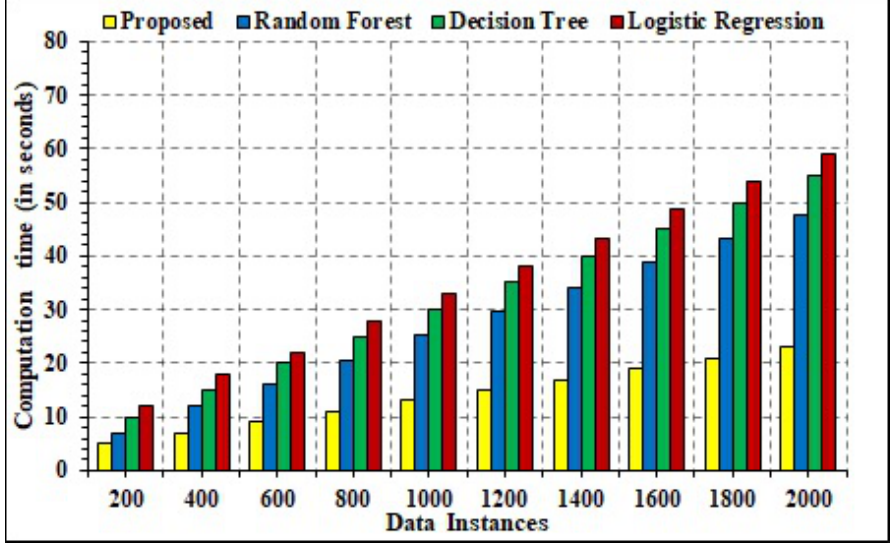
Figure 13. Temporal